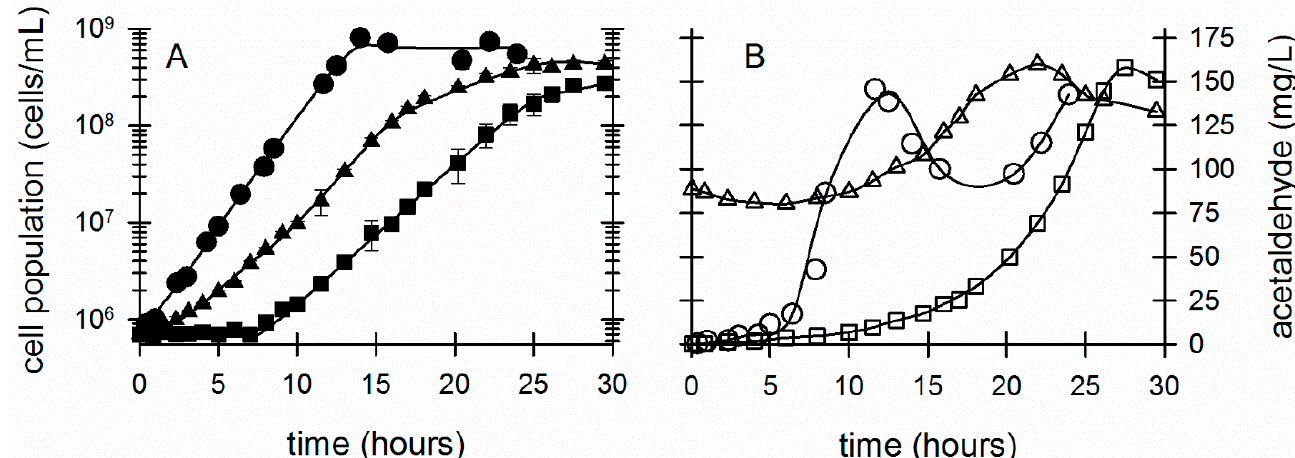
Figure 1. Effect of acetaldehyde supplementation on the growth of Z. mobilis in medium containing 50 g/L ethanol. (cid:4) , (cid:3) ethanol-stressed culture without acetaldehyde addition; (cid:115) , (cid:52) ethanol-stressed culture supplemented with 2 mM (90 mg/L) acetaldehyde; (cid:108) , control culture (without ethanol stress). ( A ) Cell population (closed symbols); ( B ) acetaldehyde concentration (open symbols).